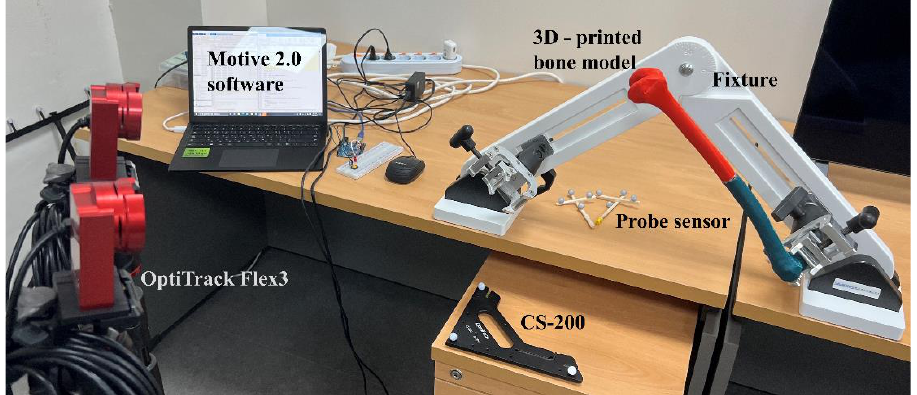
Figure 7. Experimental setup.